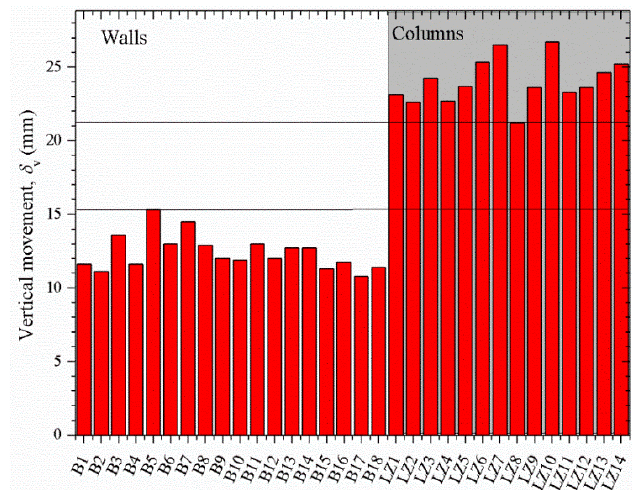
Figure 15. Vertical movements of the walls and columns at the final stage.